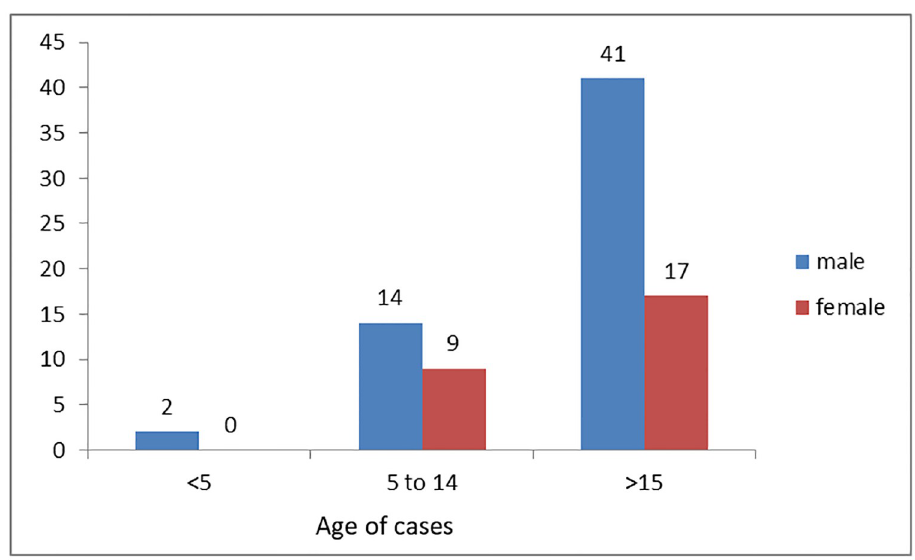
Fig 2. The proportion of HVOD deaths by sex and age, in Tahtay koraro during 2006–2016. https://doi.org/10.1371/journal.pone.0224659.g002 The incidence rate of the cases started to decrease dramatically from 86 cases in 2008/09 to 19 cases in 2009/10 in the district and from 1076 cases in 2008/09 to 242 cases in 2009/10 in Kelakil kebelle per 100,000 populations, since then the disease was started to decrease and in 20015/16 the incidence rate was only 3 and 33 cases per 100,000 populations in the district and in Kelakil kebelle respectively. As the incidence rate in the kebelle decreases, the incidence rate in the district also decreases (Fig 3). The prevalence of VOD in the district in 2015/16 was 3 cases per 1000 populations while in Kelakil kebelle 34 cases per 1000 populations. Out of the 83 deaths, 79(95%) deaths occurred in Kelakil kebelles while Tahtay adigebaro accounted for two deaths and Beles and lemlem kebelles accounted for one case each. The case fatality rate of VOD among males was 52%(57/110) while among females was 38%(26/69). In Kelakil kebelle the case fatality rate was 48% (79 out of 164). In the district, the case fatality rate Table 1. Ten year’s incidence rates of HVOD case in Tahtay koraro district, during 2006–2016. Sr.no years The incidence rate in sub kebelles per 100,000 population Incidence of the district per 100,000 population Tahtay adigebru Lemlem adigidad adimenabir